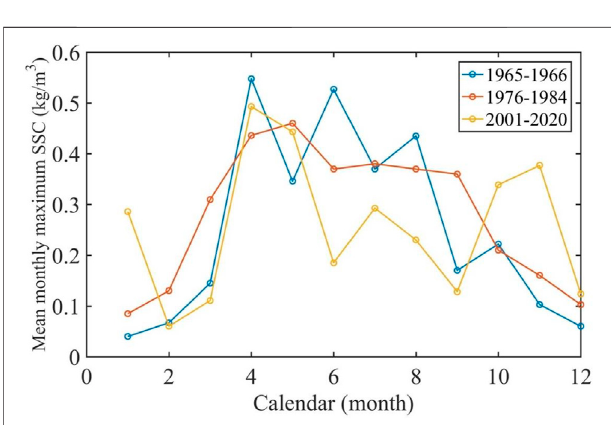
FIGURE 5 | Mean monthly maximum SSC at the three